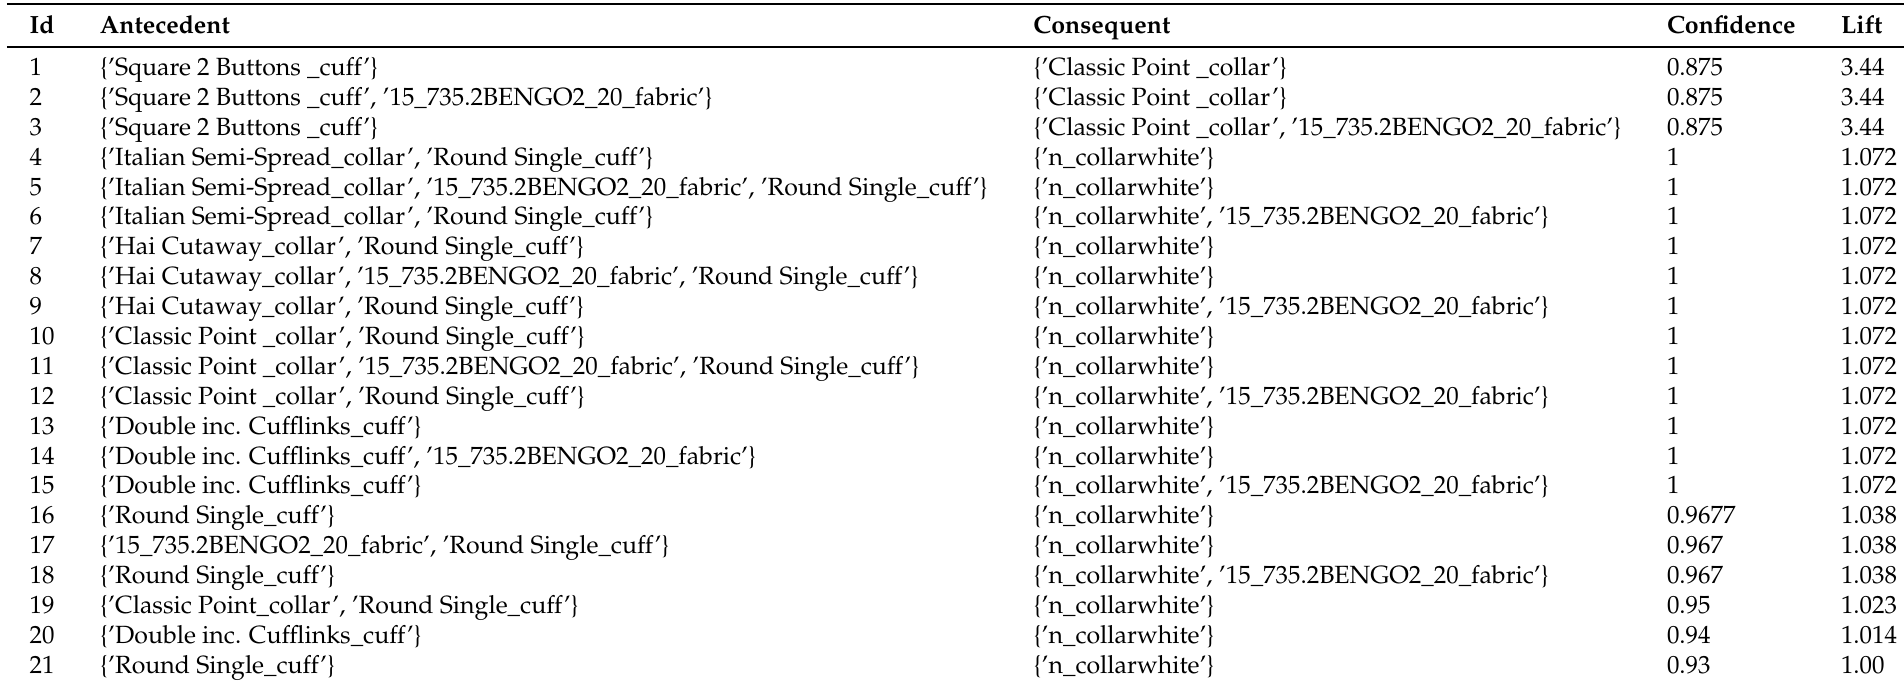
Table 5. Association rules for shirt feature